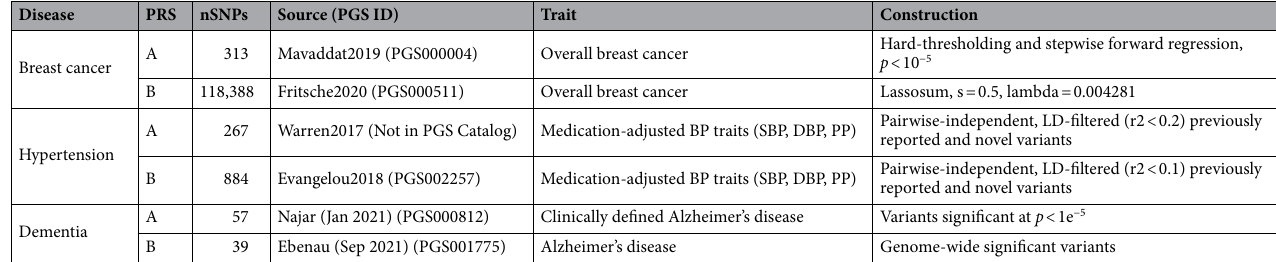
Table 1. PRS chosen for each condition. The Source column lists the paper in which each PRS was derived, along with the PGS ID (Polygenic score ID in PGS Catalog) where available. The “Construction” column outlines the derivation method of each PRS, as described in its source paper. For a brief summary of the dataset(s) where each score was derived, see Supplementary Table 1. For more detailed information about each PRS, please see its source